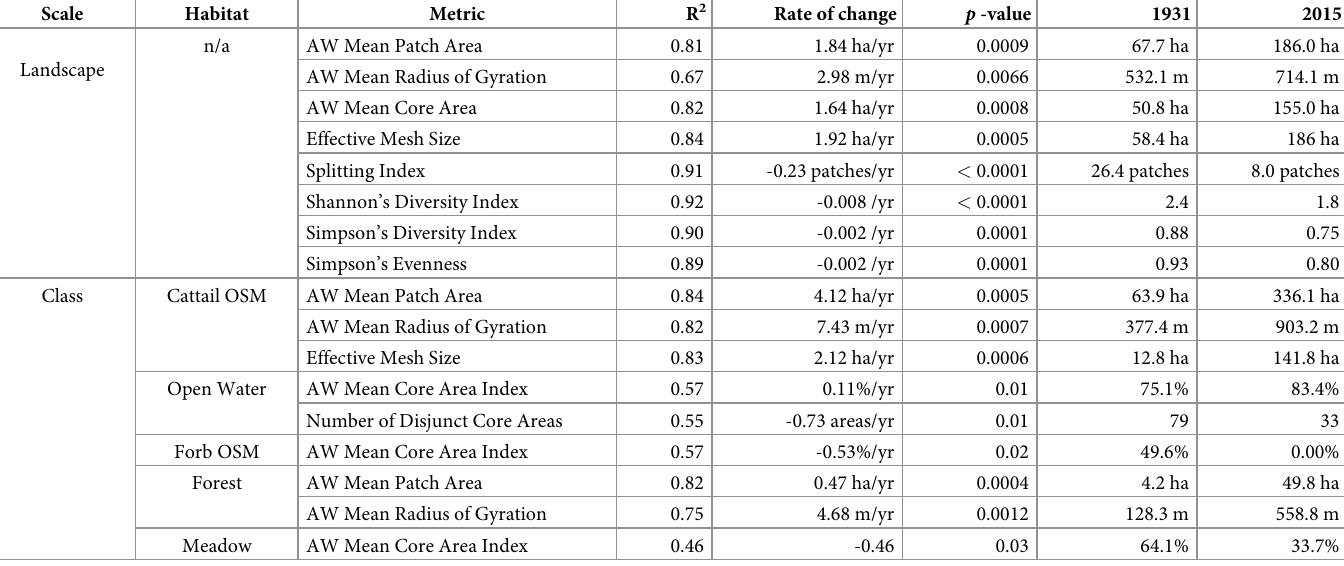
Table 3. Metrics used to describe habitat changes in Point Pelee National Park at the landscape and class scale. Scale Habitat